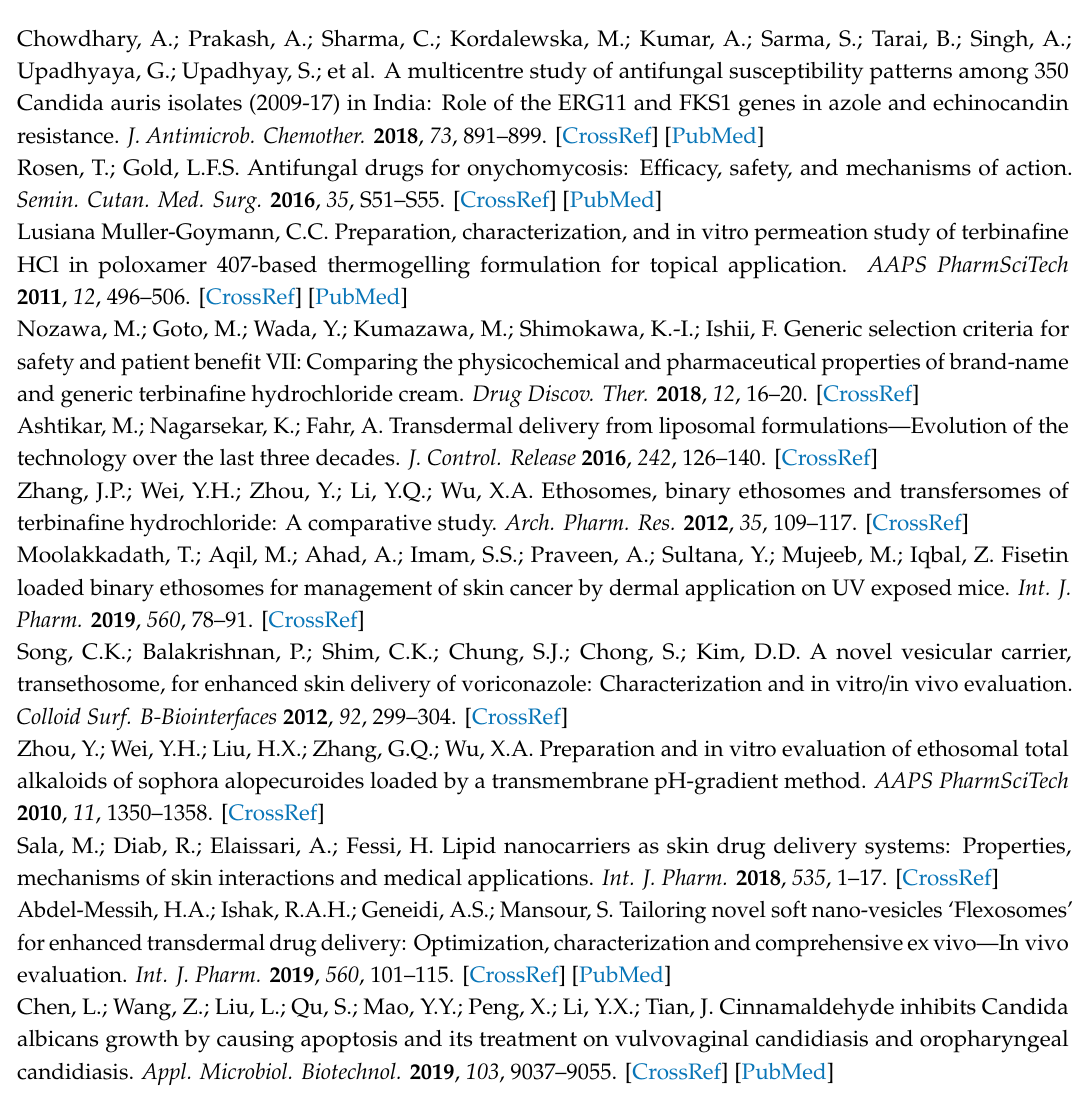
Figure S1: The TH solubility in di ff erent mediums at 37 ± 0.5 ◦ C. Data are shown as the mean ± SD ( n = 3), Figure S2: ATR-FTIR investigation: Amide I (A) and amide II (B) wavenumbers of the rabbit skin treated with di ff erent